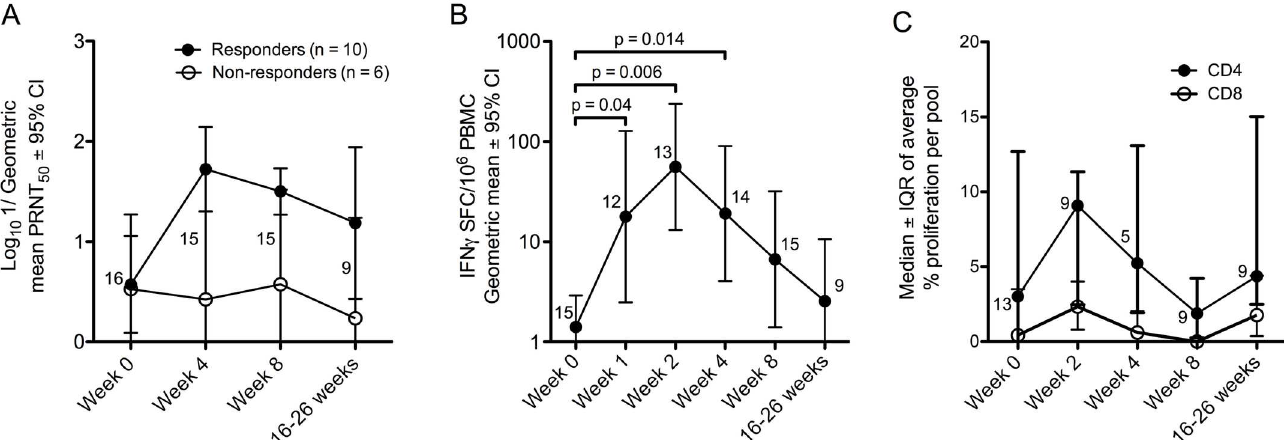
Fig 1. Antibody and cellular responses to JE vaccine SA14-14-2. (A) Neutralisation of JEV SA14-14-2 by sera from vaccinatedparticipants at 4 weeks, 8 weeks and 4–6 months after vaccination.Data are the logarithmof the geometric mean of 1/plaquereductionneutralisation titre 50% (PRNT 50 ) ± 95% confidenceinterval (CI). Filled circles = responders, open circles = non-responders. The numberof participants with data at each time point are indicated.(B) IFN γ -ELISpot responses to a peptidelibrary of JEV SA14-14-2 after vaccination.Data are the geometric mean of the sum of spot forming cells (SFC)/10 6 PBMC for all respondingpools (per participant) after subtractionof background wells at each time point ± 95% CI. Non- respondingpools were not included.The number of participants is indicatedas in (A). Responses were significantlyincreasedover baselineat weeks 1, 2 and 4 (Wilcoxonsigned rank test). (C) Proliferation responses in 13 JE vaccinated individuals.Data representthe average% responding cells (CFSE lo /CD38 hi ) measuredby flow cytometry across all peptidepools tested in the CD4 + (filled circles) or CD8 + (open circles) gate. Data points are the median and error bars depict the interquartile range (IQR). The numberof participantsis indicatedas in (A).